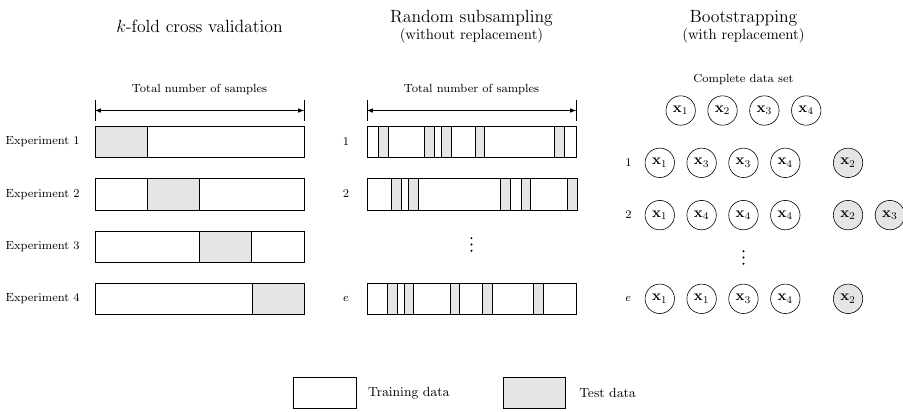
Figure 3. Examples of methods for estimation of model generalization accuracy. Schematic overview of three common validation strategies: k -fold cross validation, random subsampling, and bootstrap- ping (with replacement). The white shapes denote the training data, whereas grey shapes denote testing data. Here, e represents the total number of experiments to